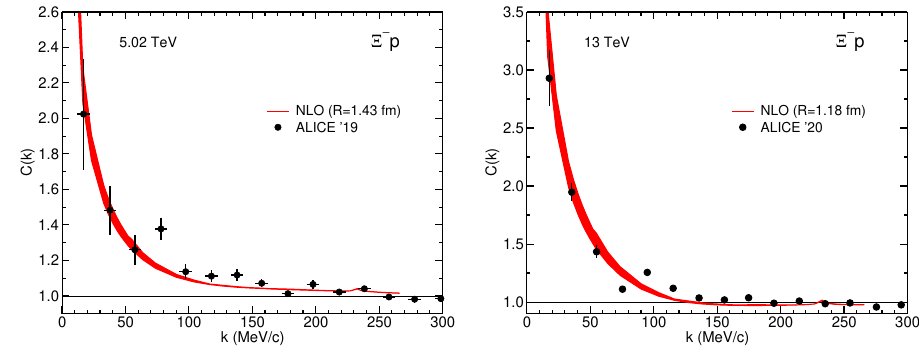
Figure 5. Predictions for the Ξ − p two-particle momentum correlation function C ( k ) of our NLO poten- tial [6]. Data are from the ALICE Collaboration [39,